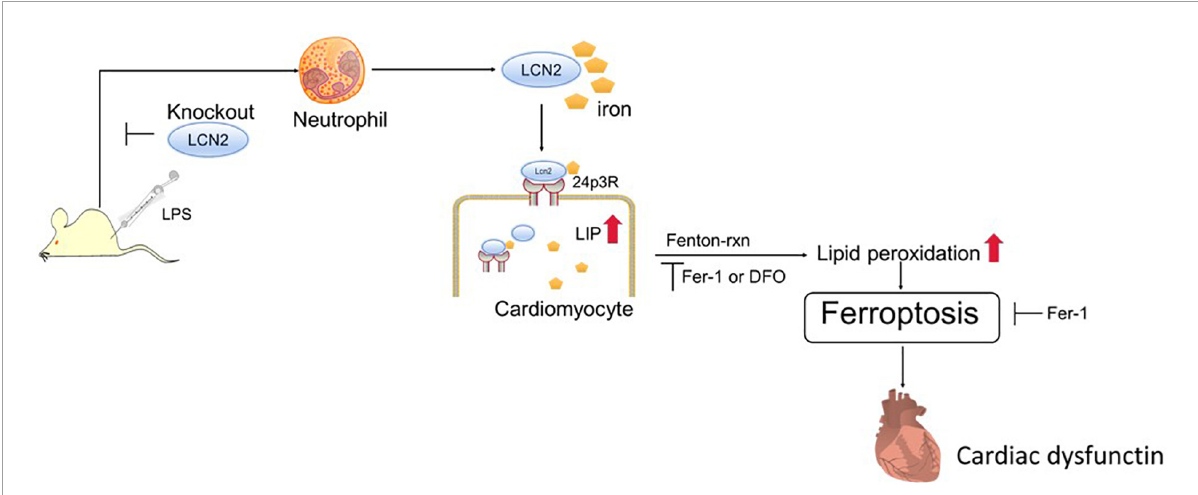
FIGURE6 LCN2 and its potential mechanism on SCD. Neutrophil-derived LCN2 initiates intracellular LIP elevation via 24p3R, triggers ferroptosis, and eventually contributes to cardiac